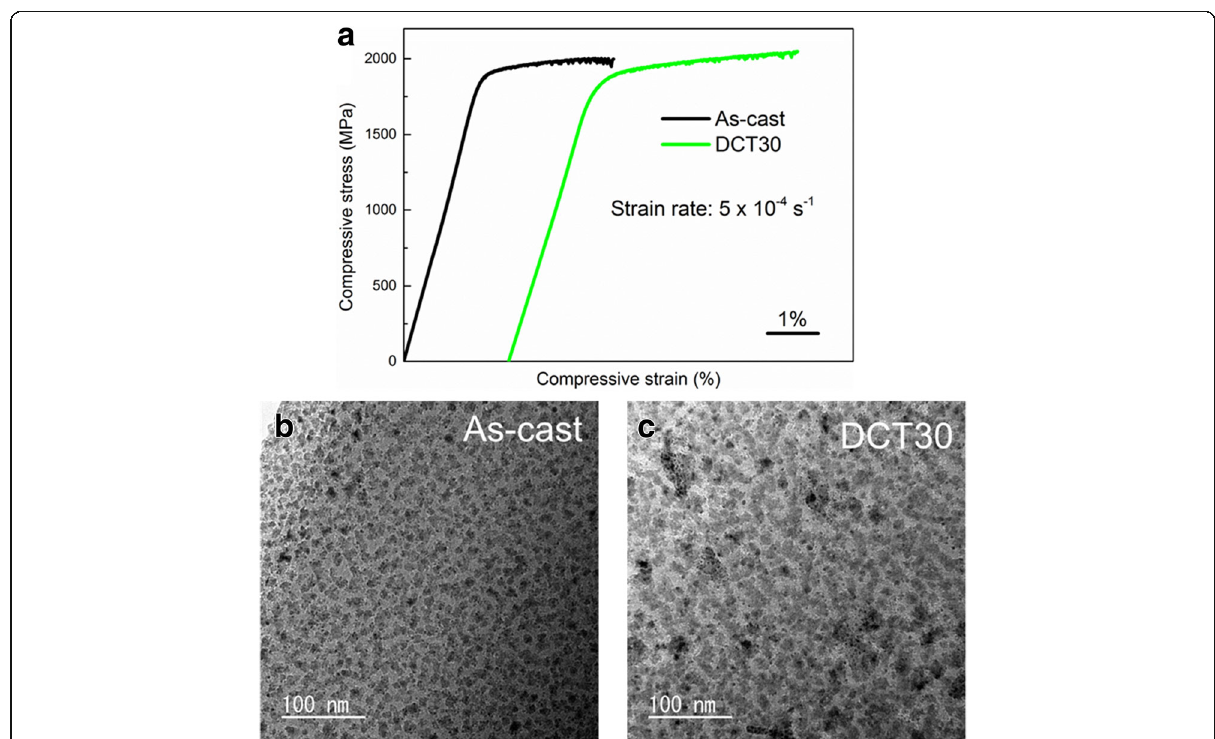
Fig. 4 a Compressive stress-strain curves of As-cast and DCT30 samples cast at LT. b , c Bright-field TEM images of As-cast and DCT30 samples cast at